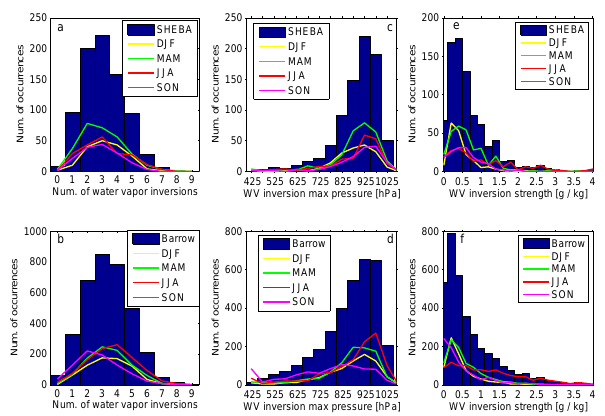
Fig. 10. The total (bars) and seasonal (lines) RFDs of (a–b) the to- tal number of WV inversions identified; (c–d) The vertical pressure level (hPa) of the maximum WV MR for the inversion structure con- taining the largest absolute WV MR; (e–f) The inversion strength (gkg − 1 ) of the inversion structure containing the largest absolute WV MR. SHEBA statistics are on the top row while Barrow’s are on the lower